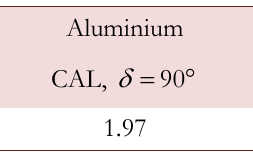
Table 7: Multiaxiality factor according to Susmel,